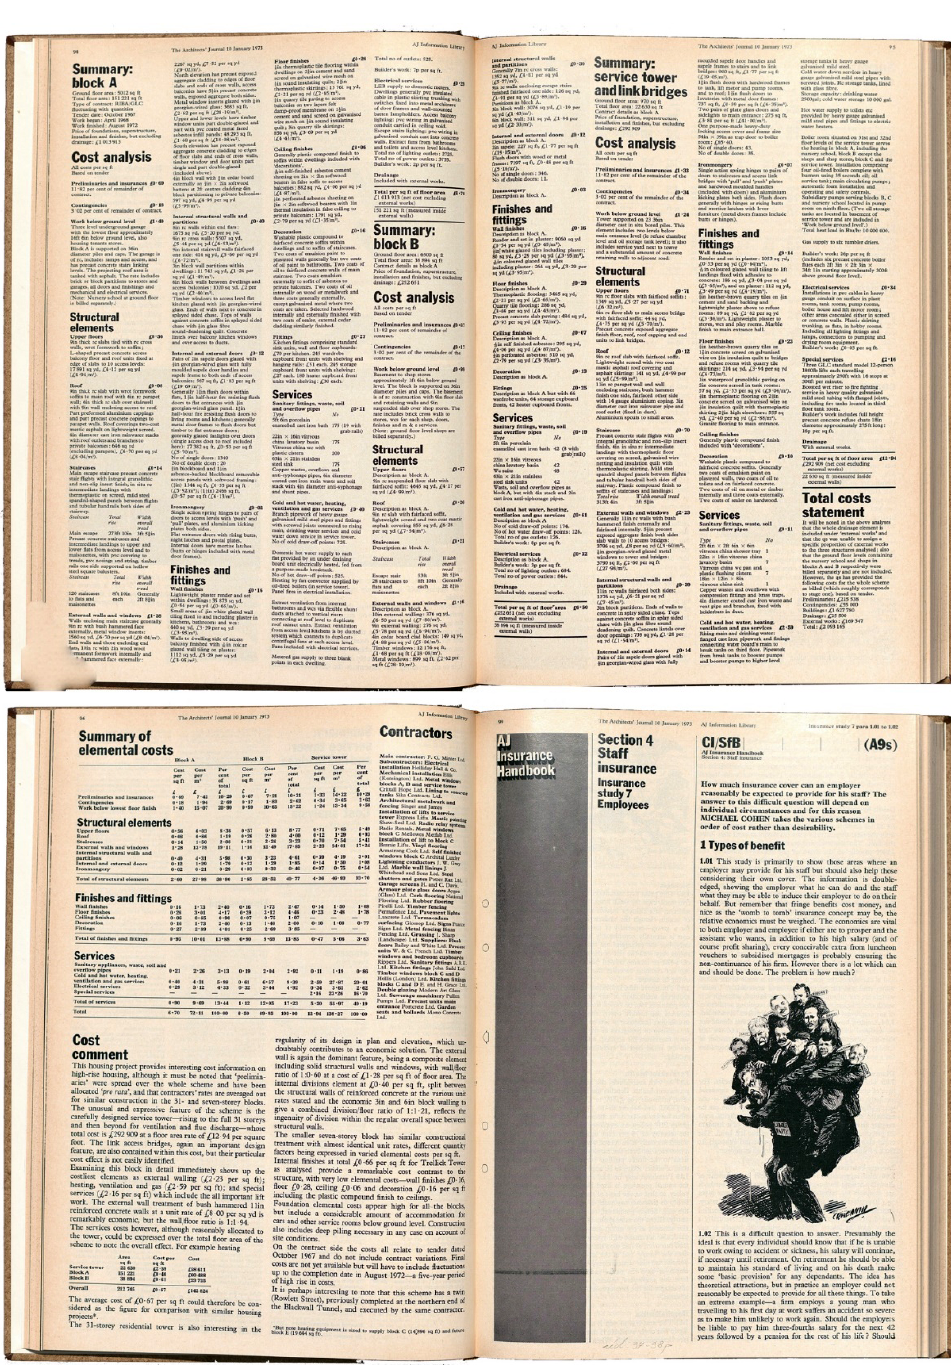
Figure 14. Richardson M. (1973). Cheltenham Estate housing, Architects’ Journal , 157